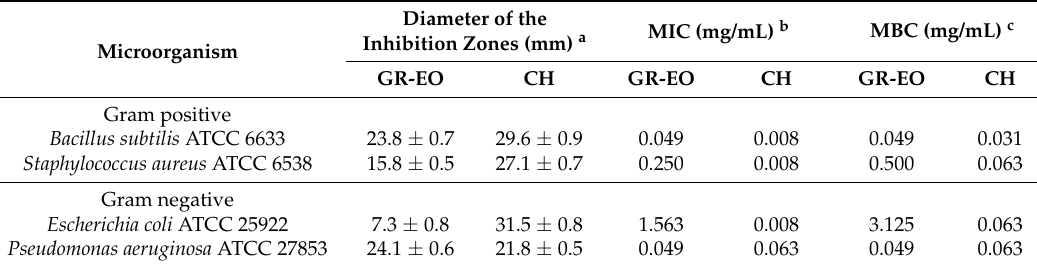
Table 2. Antibacterial activity of